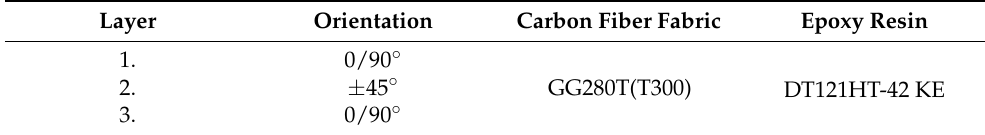
Table 2. Characteristics of experimental CFRP composite.